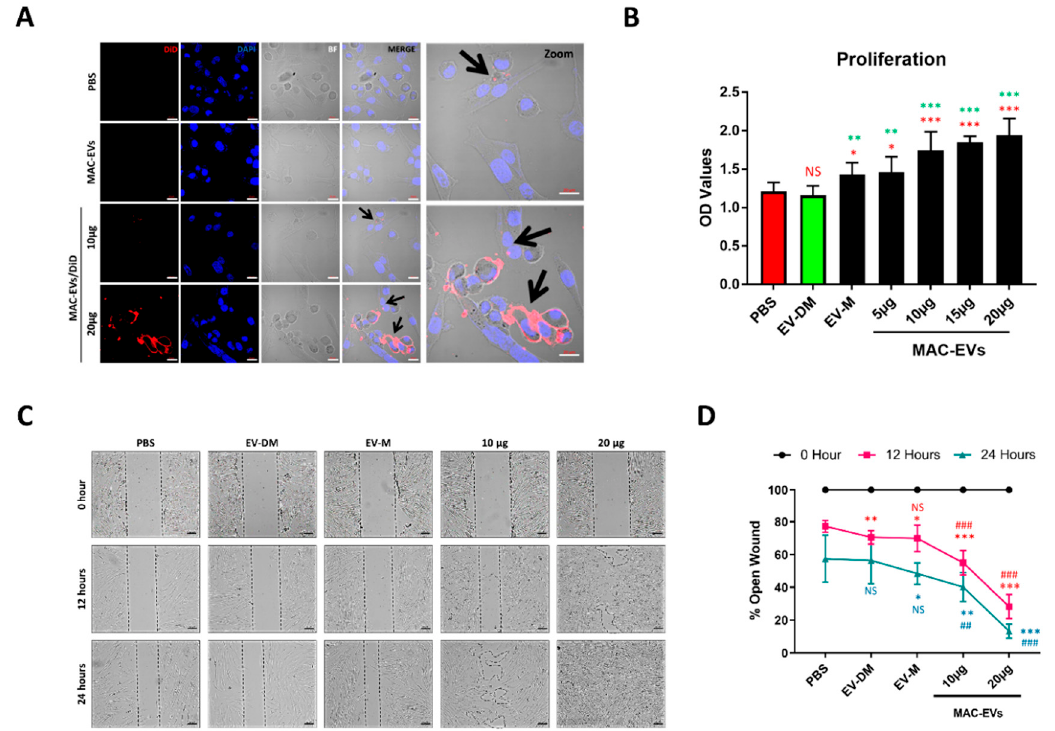
Figure 3. Interaction of MAC-EVs with DP cells leads to cell migration and proliferation. ( A ) DP cells incubated with either PBS, non-labelled MAC-EVs, and DiD-labelled MAC-EVs (MAC-EVs/DiD), arrows indicate the internalization, scale bar: 20 µm. ( B ) Proliferation of DP cells shown in dot blots obtained by CCK8 assay after 24 h of treatment with MAC-EVs (0 to 20 µg), Student’s t-test was used. A red color * indicates PBS versus other and green color * indicates EV-DM versus EV-M and MAC-EVs. ( C ) Phase contrast microscopy images of migrated cells in 12 and 24 h, scale bar: 100 µm. ( D ) Quantified data of migrated cells shown in ( C ), Student’s t-test was used. * indicates PBS versus others; # indicates EV-DM versus EV-M and MAC-EVs. * p < 0.05; ** or ## p < 0.01; *** or ### p < 0.001. EV-M; media containing EVs; EV-DM; media containing no EVs.